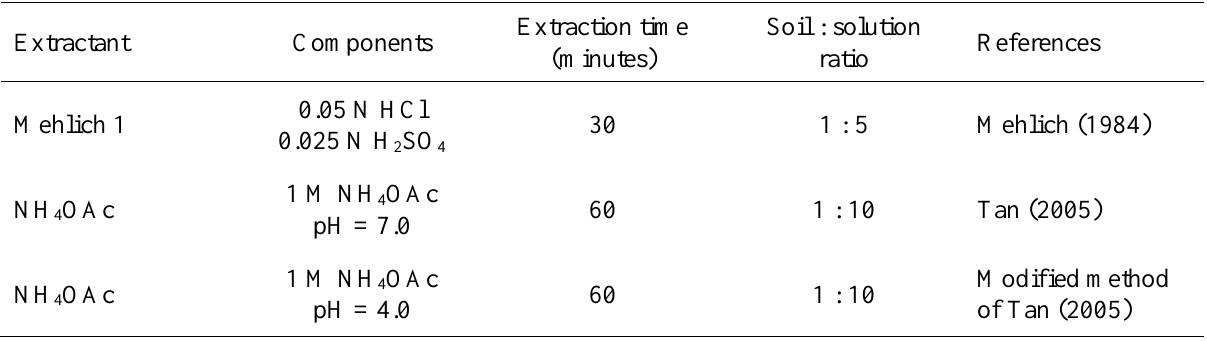
Table 1. The three extractants used for determination of available K, Ca and Mg.